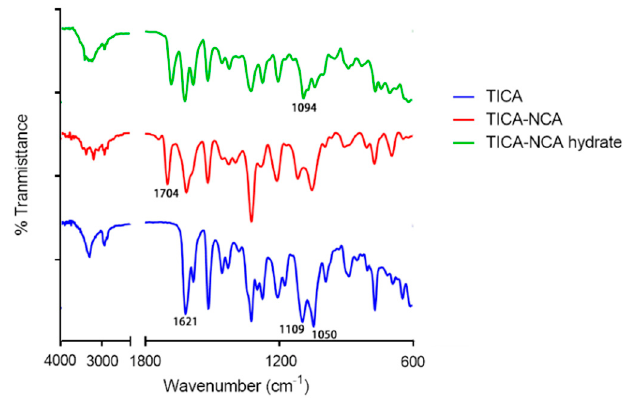
Figure 4. The FT-IR spectra of TICA, TICA-NCA, and TICA-NCA hydrate.